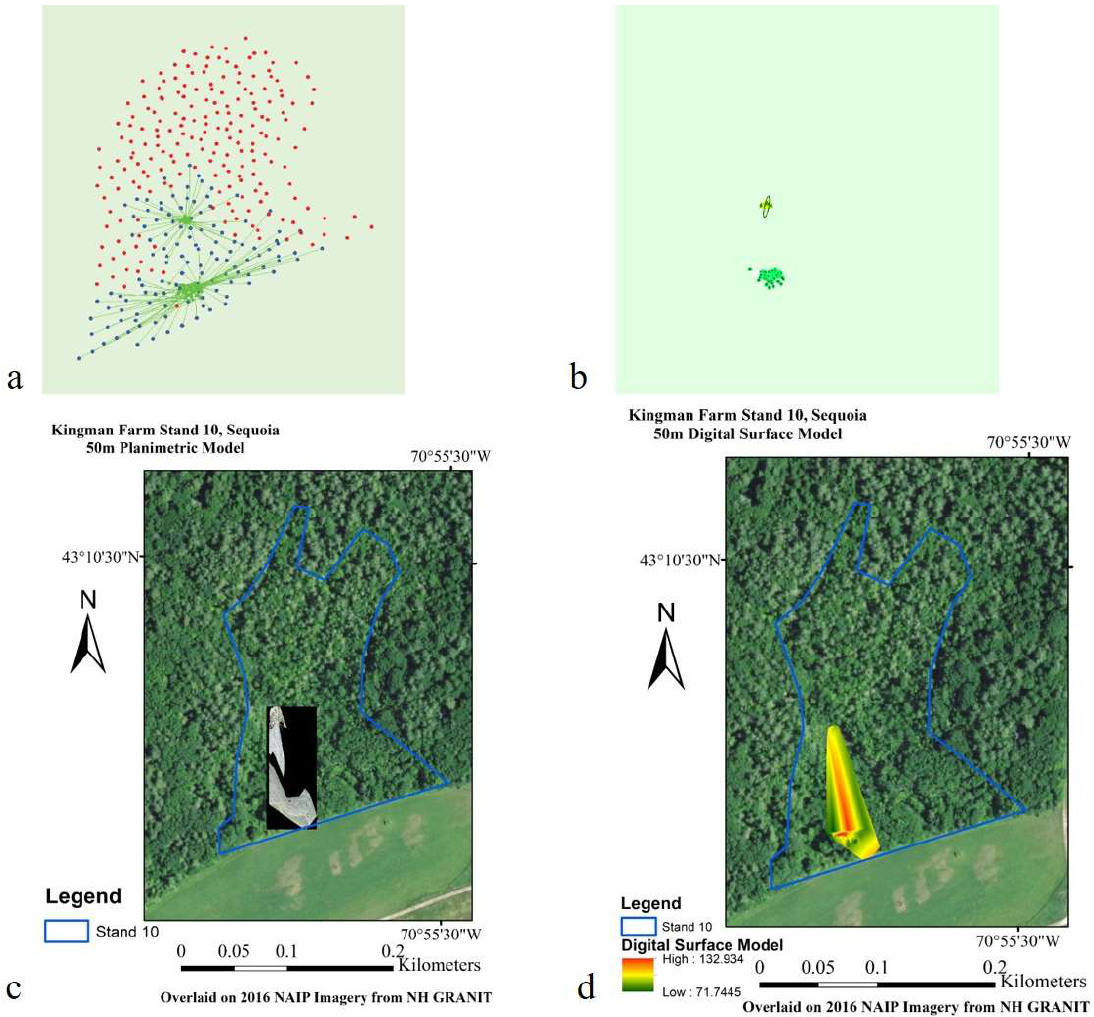
Figure 4. Pix4D mapper Pro initial processing results for the Sequoia red–green–blue (RGB) multispectral sensor at a 50-m flying height above the canopy height model: ( a ) image alignment success (green), failure (red), and additional uncertainty in image location (green lines to blue location); ( b ) image-matching strength (gradient of the line network), and image geolocation certainty (circle area); ( c ) final orthomosaic product; and ( d ) DSM.